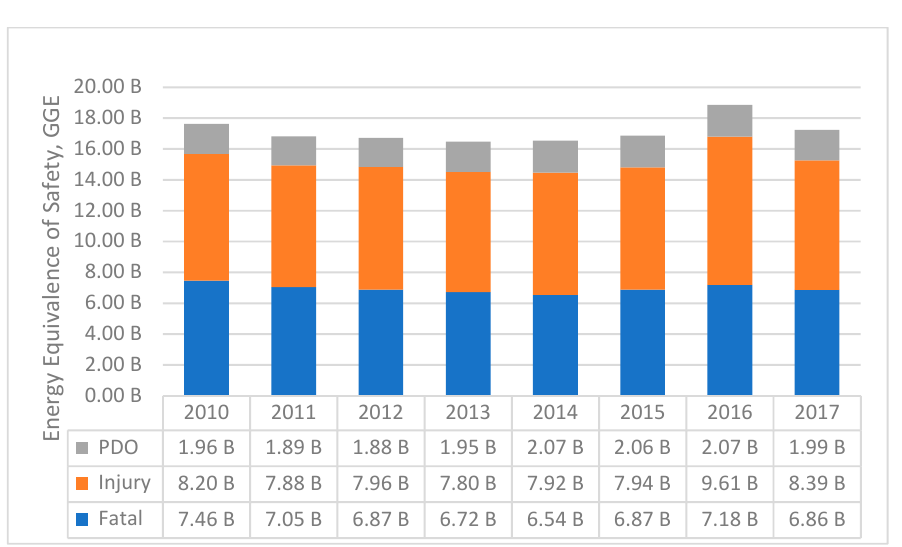
Figure 6. Change of energy equivalence rate (EER).